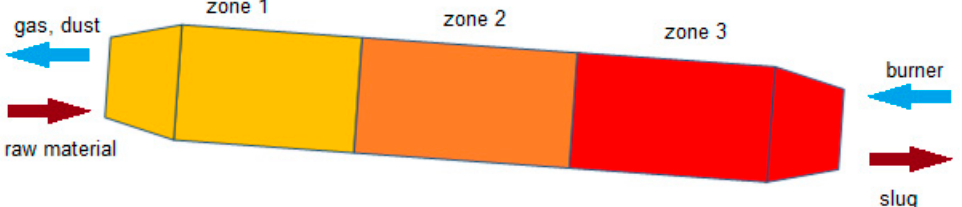
Figure 1. Scheme of the Weltz process with rotary kiln [12,13]: the colors of the drawing correspond to the zones of the furnace (yellow, orange, and red zones are 1, 2, and 3, respectively). Due to the temperature distribution, three zones can be distinguished in the fusing furnace, as shown in Figure 2.